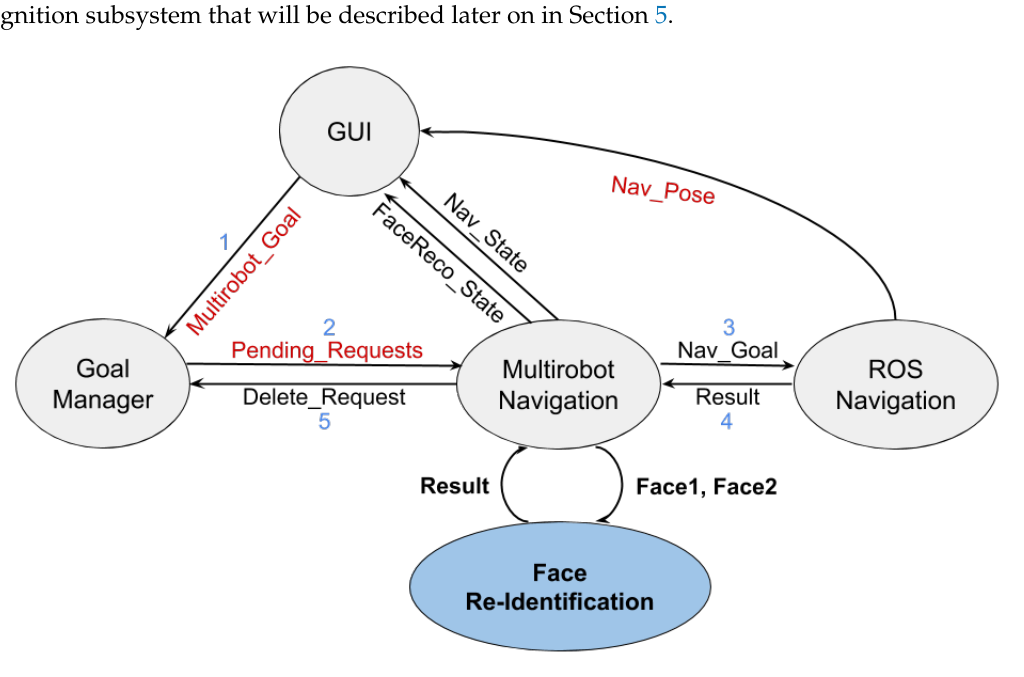
Figure 1. Communication among system